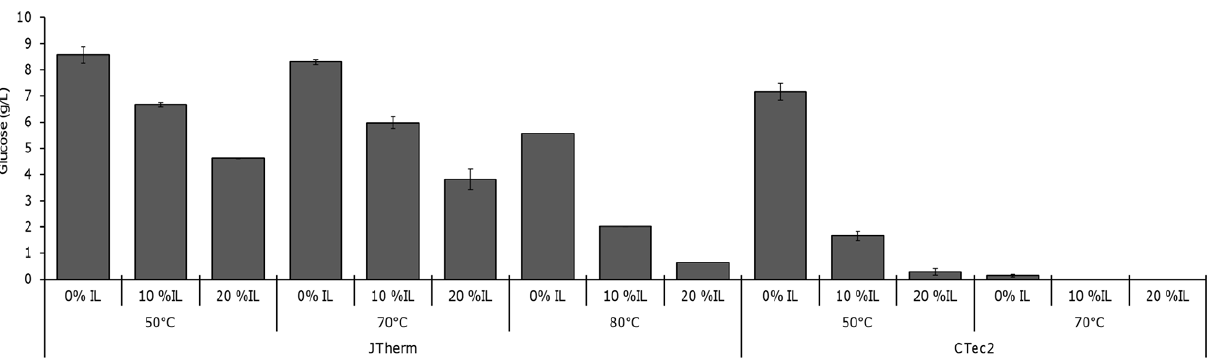
Figure 4. Activity of the JTherm and CTec2 cellulase cocktails on ionic-liquid pretreated switchgrass at various temperatures and in the presence of the ionic liquid [C2mim][OAc]. Samples were run at 2.5% w/v biomass loadings in 1 ml and incubated at pH 5.5 for 72 h with shaking.